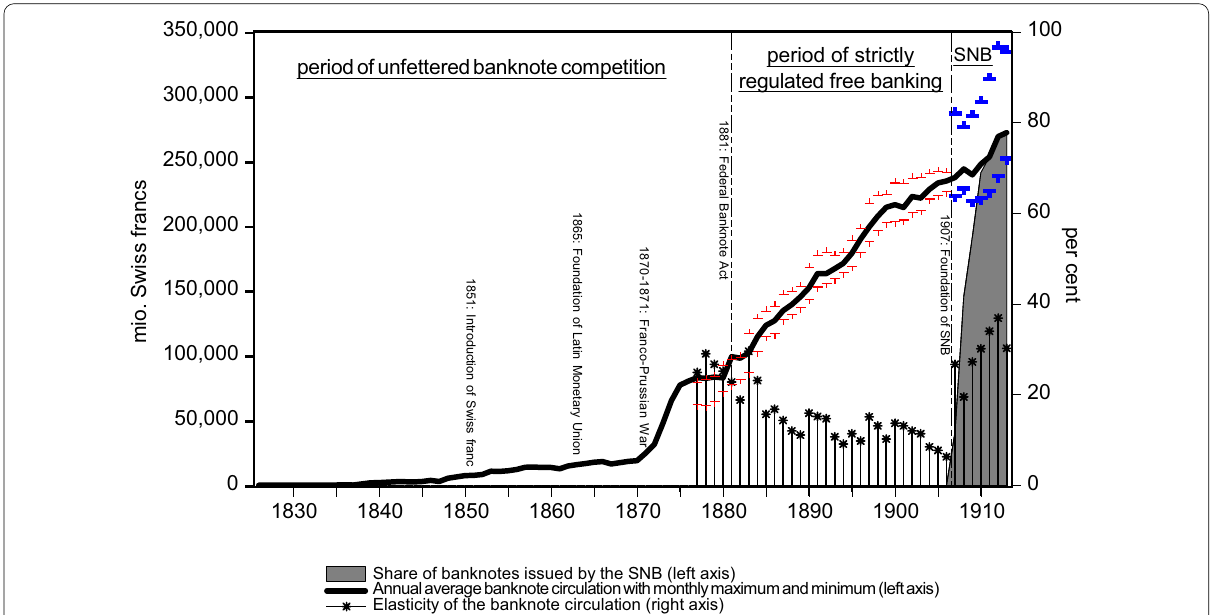
Fig. 1 Banknotes in Switzerland (1826–1913). Notes : The data have an annual frequency and cover the 1826–1913 period. Banknote circulation refers to the annual average across months as reported by Jöhr (1915, pp.496–497). The corresponding monthly maxima, which are denoted by ⊥ and occurred usually in December, and minima, which are denoted by ⊤ and occurred usually in February or March, are also taken from Jöhr (1915, p.500). Between 1877 and 1882, the corresponding data do not cover all note-issuing banks (Jöhr, 1915, p.415). Following Jöhr (1915, p.500), the annual “elasticity of the banknote circulation” is reported in terms of the spread (e.g. the difference between the maximal and the minimal circulation as a percentage of the average banknote circulation during a given